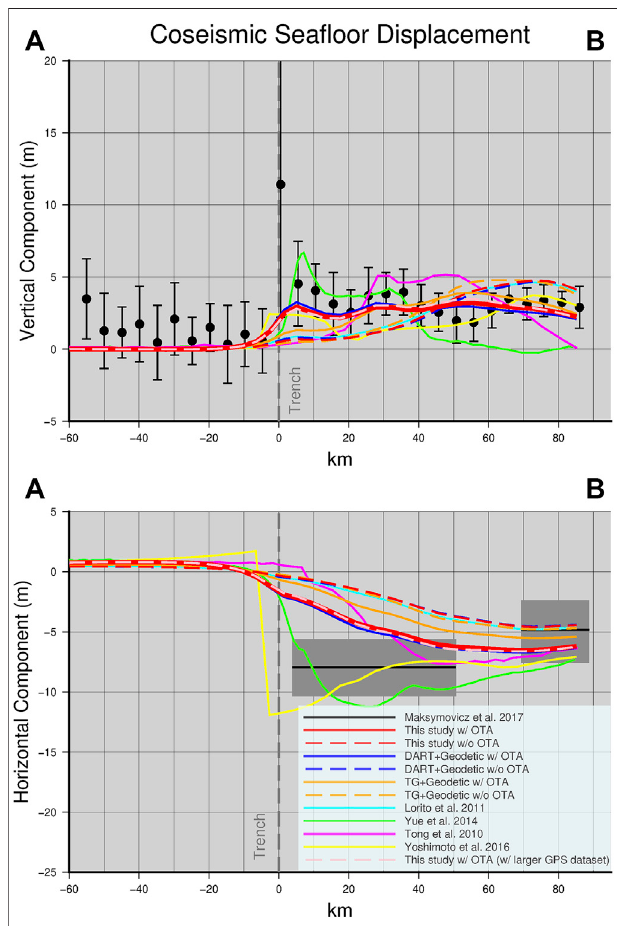
FIGURE 15 | Comparison between observed (black) and predicted (A) vertical and (B) horizontal sea fl oor deformation along the ILOCA track; in (A) error bars indicate the standard deviation, whereas in (B) the approximated error bars are in grey. In both panels, predicted sea fl oor deformations are shown for the slip distributions obtained for all cases investigated in this study (with and without OTA along with predictions for the Yue et al. (2014, green), Tong et al. (2010, magenta), and Yoshimoto et al. (2016, yellow) models. Dashed grey vertical line in both the panels indicates the trench location along the ILOCA